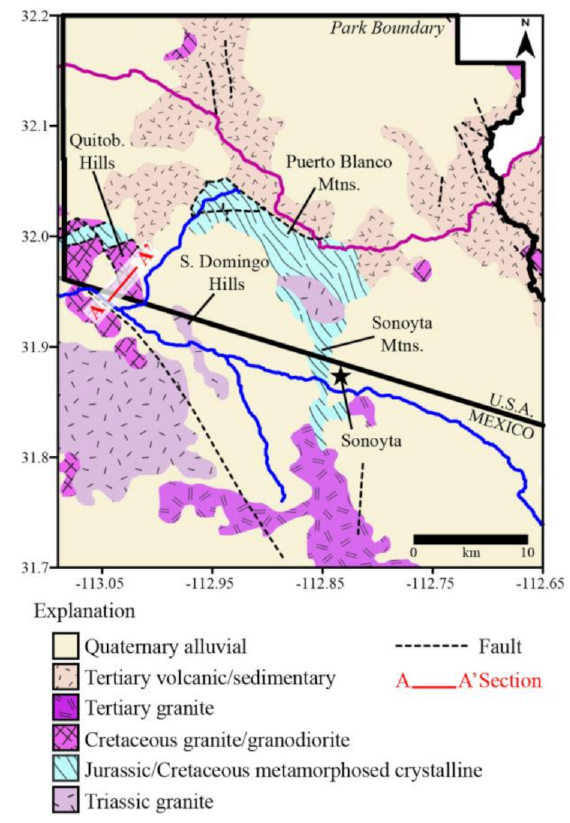
Figure 4. Geology of study area. Pink line shows the watershed boundary. Black star symbol shows the location of Sonoyta, Sonora. Map includes data from [34] in the U.S., and from [35] in Mexico. Basin-fill consists of mainly unconsolidated to weakly consolidated gravels, sands, and silts that overlie pediments on lower slopes, occurring as a set of overlapping and interconnected lenses of alluvium and slope wash adjacent to range fronts [34]. These basin-fill deposits extend outwards from the range fronts as alluvial plains sloping down towards the Sonoyta River Valley where their depths may exceed 300 m. Stream channels have been cut into the less-permeable basin-fill. These deposits are left behind by ephemeral streams (e.g., Aguajita Wash, Figure 2) that originate in the nearby mountains and merge with the Sonoyta